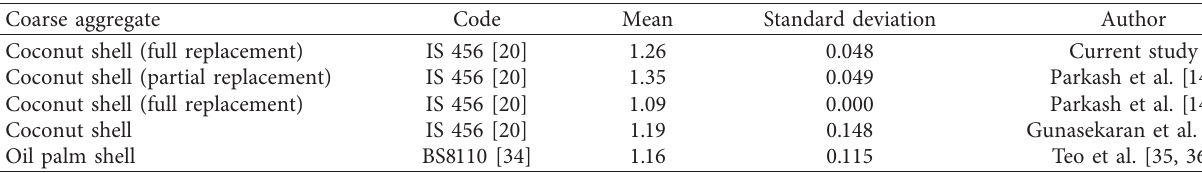
Table 7: Comparison of the capacity ratio of LWC with others.